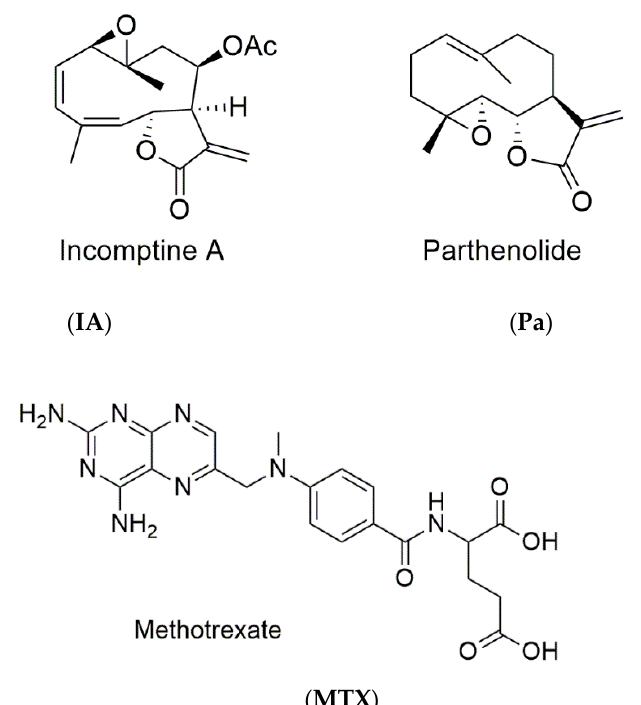
Figure 1. Structures of incomptine A ( IA ), parthenolide ( Pa ), and methotrexate ( MTX ). Table 1. Antilymphoma, lethality, and toxic activities of incomptine A ( IA ) and the dichloromethane extract of the aerial parts from D. incompta .